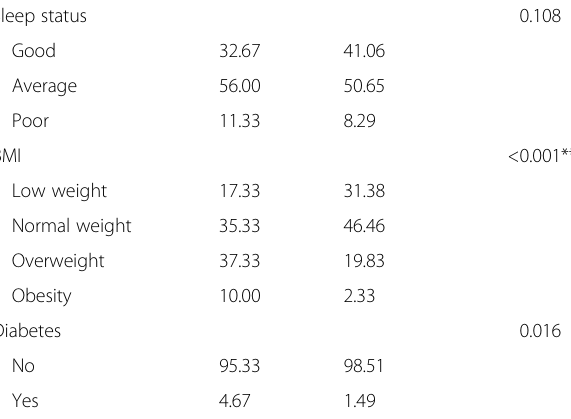
Table 1 Characteristics of the study participants, Chongqing,